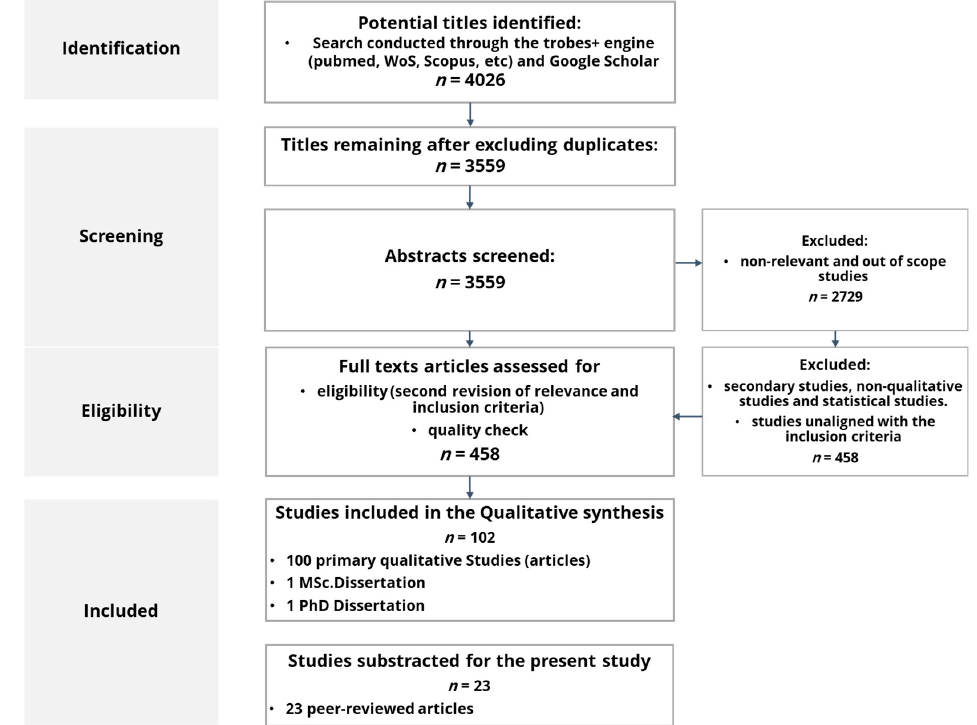
Figure 1. Search strategy and result diagram.